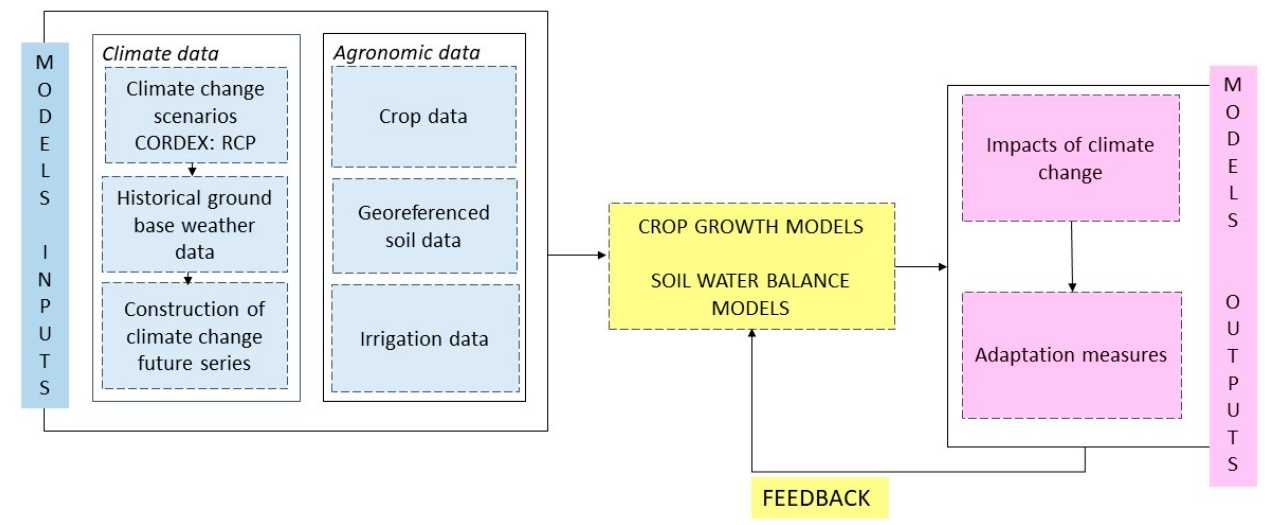
Figure 4. Schematic representation of the most common conceptual approaches applied to assess the impacts of climate change on Agriculture using crop growth and SWB models. impacts of climate change on Agriculture using crop growth and SWB